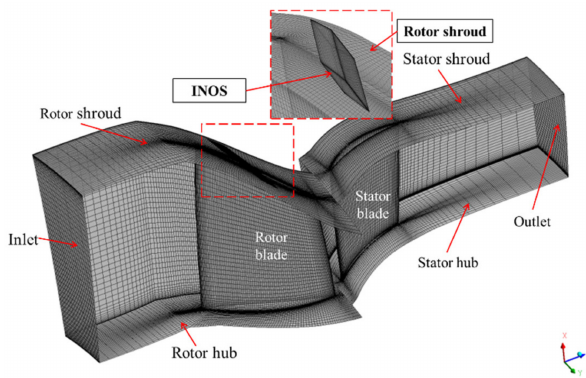
Figure 2. Computational